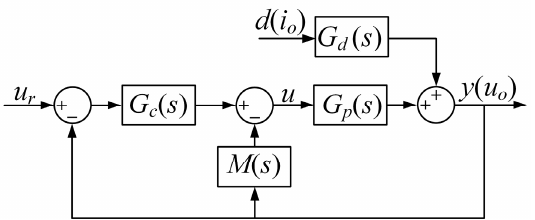
Figure 7. Equivalent control block diagram of inverter with SRFPI-LADRC.